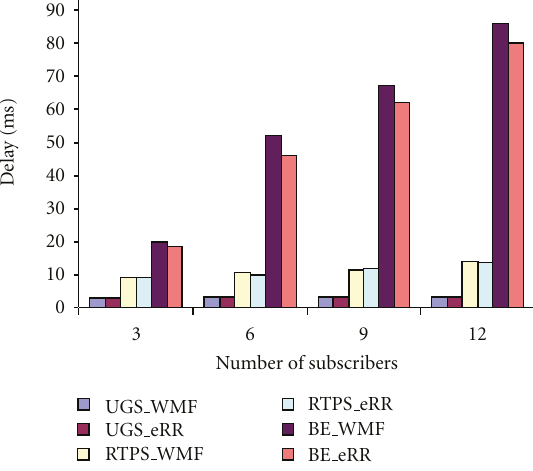
eRR service class and tra ffi c priority Delay (ms)